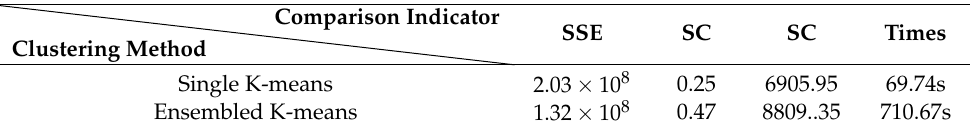
Table 2. Comparison index values of clustering results of ensembled K-means and single K-means of landings.